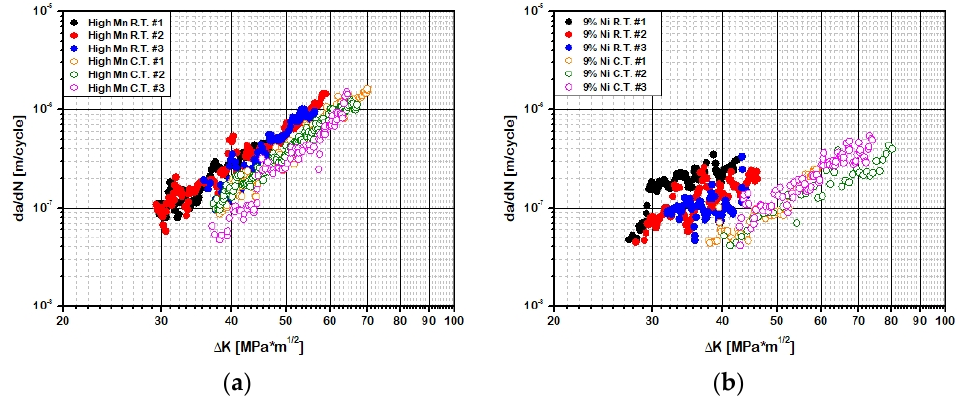
Figure 14. da / dN - Δ K curves of weld metals: ( a ) high Mn; ( b ) 9% Ni. Table 7. FCGR test results of weld metals.